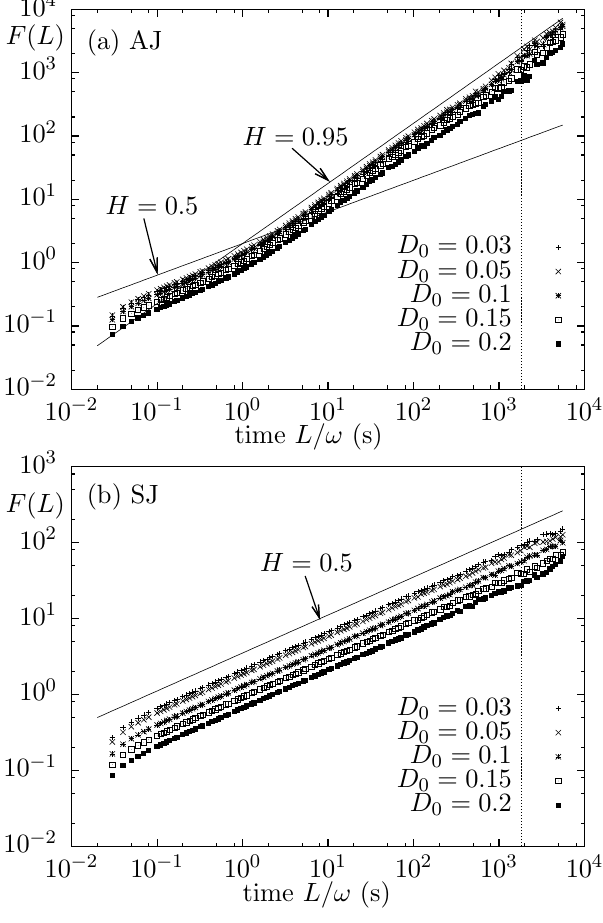
Fig. 8. Same as Fig. 7, but with events extracted from the fluctuat- ing signal defined in Eq. (23).